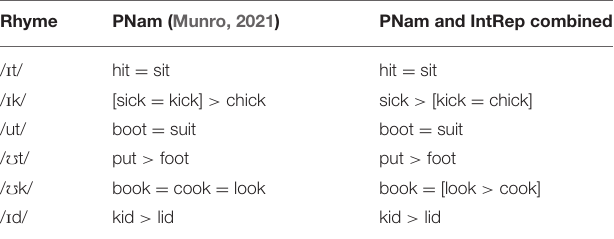
TABLE 7 | Post-hoc comparisons * of %-correct ID for words with identical rhymes.